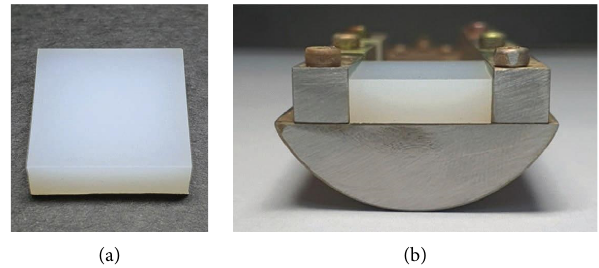
Figure 1: (a) A UHMWPE sample and (b) the custom holder are shown.